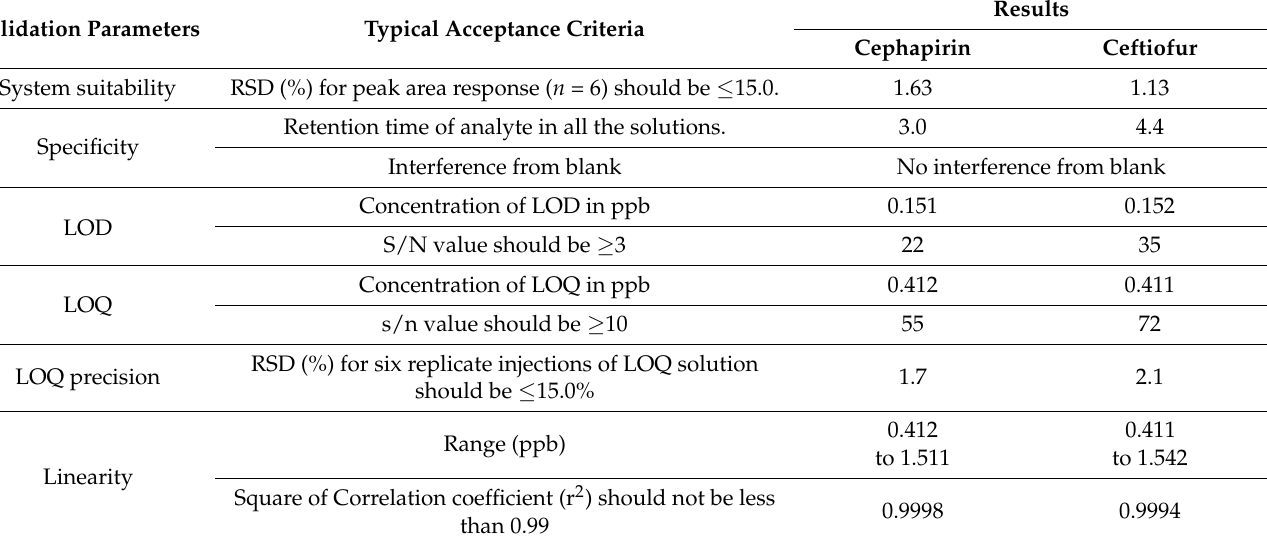
Table 1. Summary of method validation